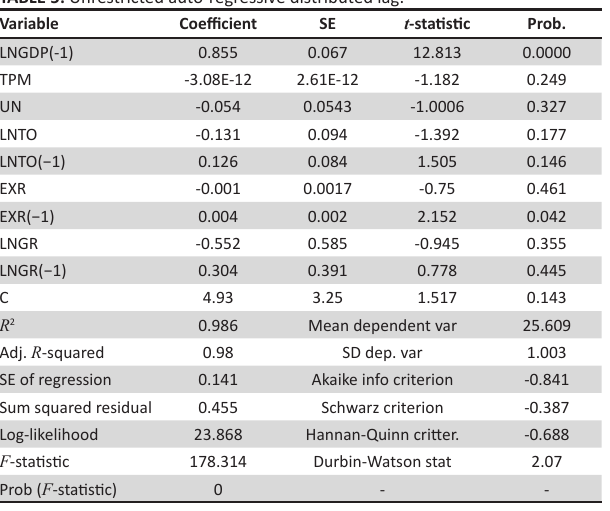
TABLE 5: Unrestricted auto-regressive distributed lag. Variable